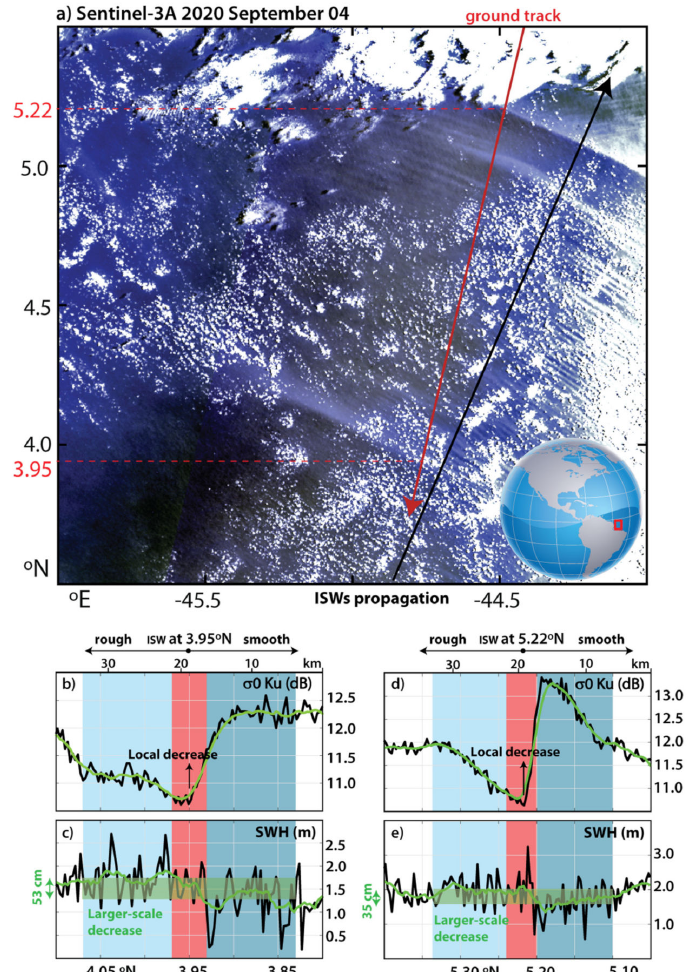
Figure 4. ( a ) Quasi-true color image (Level-1b) acquired on 4 September 2020 at 13h01m UTC by the OLCI sensor onboard the Sentinel-3B satellite (see inset for location). The red line represents the ground-track of the satellite, which in this case is practically parallel to the ISWs’ direction of propagation. ( b ) Along-track 20 Hz NRCS (i.e., σ 0 ) measured by the SRAL altimeter showing variations of approximately 2 dB in the leading ISW around 3.95 ◦ N. ( c ) SWH 20 Hz for the same ISW showing a larger-scale variation of 0.53 m when comparing the section in front of the leading wave with that in the rear. ( d ) Same as ( b ) for the leading ISW around 5.22 ◦ N, with variations of approximately 3 dB ( e ) Same as ( c ) showing a larger-scale variation of 0.35